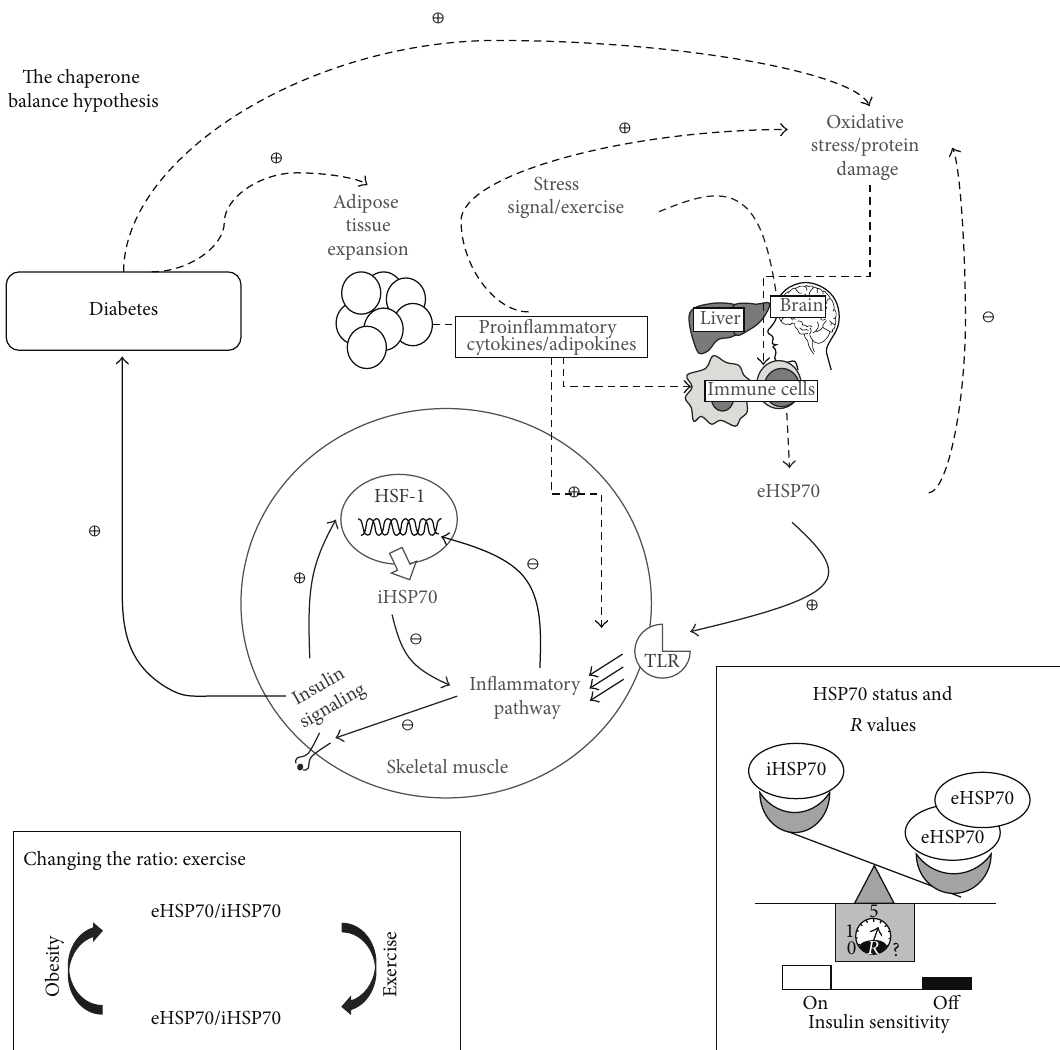
Figure 1: The chaperone balance. Adipose tissue expansion leads to chronic release of proinflammatory cytokines and adipokines. The low-grade inflammation can induce (i) activation of NF- 𝜅 B-dependent inflammatory pathways leading to the blockage of iHSP70 and to insulin resistance, (ii) release of proinflammatory eHSP70 chronically from immune cells, and (iii) ROS and RNS, oxidative/nitrosative stress that leads to protein damage and denaturation. eHSP70 is increased as a danger signal and to combat the plasma oxidative damage; however, when chronically elevated, it (i) induces further immune activation and proinflammatory response and (ii) activates TLR and the inflammatory pathway leading to the reduction of HSF-1 activation and eventually to reduced iHSP70. Lower iHSP70 causes (i) reduced insulin sensitivity, (ii) intensification of the NF- 𝜅 B activation and inflammation, and (iii) reduced antioxidant, antiapoptotic, and anti- inflammatory capacity. The long-term insulin resistance determines the onset of diabetes, completing this positive feedback mechanism. Lower panels: when the eHSP70/iHSP70 ratio chronically changes in favor of eHSP70, the “insulin sensitivity button” is switched off and 𝑅 values ([eHSP70]/[iHSP70]) rise; exercise induces iHSP70 expression while the release of eHSP70 responds in an opposite manner. 𝑅 values between 0 and 1 indicate an anti-inflammatory status and between 1 and 5 indicate an optimum immunoinflammatory surveillance status, while 𝑅 values above 5 suggest an undesirable chronic proinflammatory